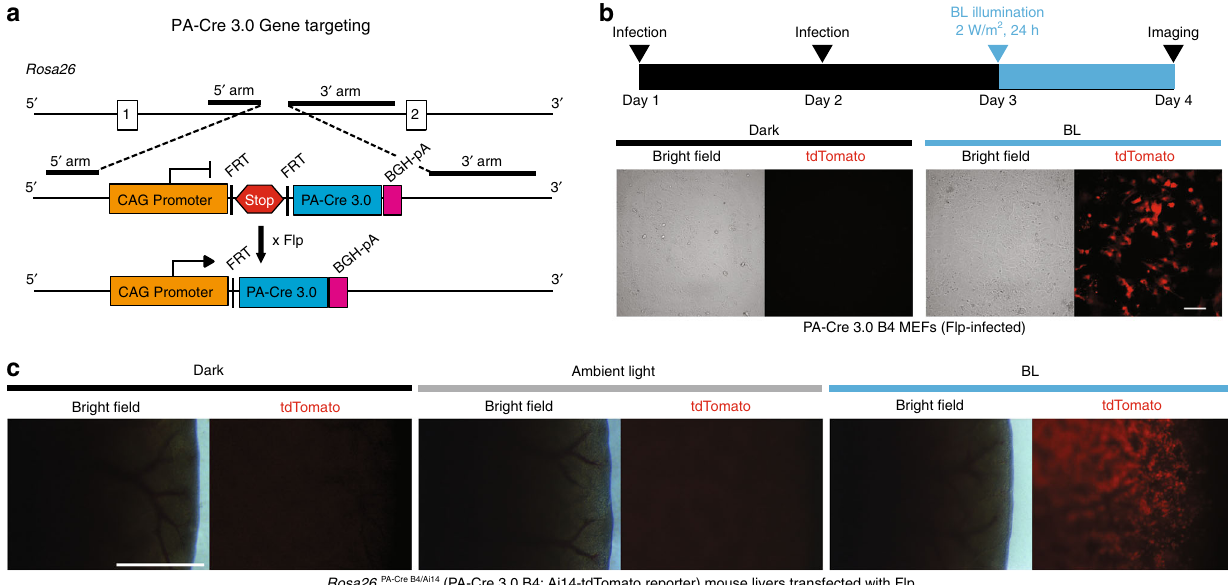
Fig. 5 Cre recombination induced by blue light in vivo PA-Cre 3.0 mouse. a Schematic representation of PA-Cre 3.0 mouse targeting strategy. PA-Cre 3.0 knocked-in to Gt(ROSA)26Sor ( Rosa26 ) locus with CAG promoter and stop sequence added between FRT cassettes. Flp-mediated excision of the FRT- fl anked stop cassette (Stop) induces PA-Cre 3.0 expression. b Representative bright fi eld and tdTomato fl uorescent images of mouse embryonic fi broblast cells derived from Rosa26 PA-Cre B4/Ai14 mouse line illuminated with blue light. Diagram showed the experimental time course. The CAG-Flpe lentivirus was infected at the serial 2 days. The following day, the cells were illuminated for 24 h (470 ± 20 nm, 2 W/m 2 , 24 h continuous) ( n = 3, Scale bar: 100 μ m). c Representative liver images freshly isolated from Rosa26 PA-Cre B4/Ai14 mice. CAG promoter-mediated Flp plasmids were transfected into PA-Cre 3.0 B4 mouse livers using HTV method. The mice were maintained in the dark, ambient light, or under blue-light illumination (470 ± 20 nm, 200 W/m 2 , 16 h continuous) ( n = 3 – 4 mice/group, Scale bar: 1